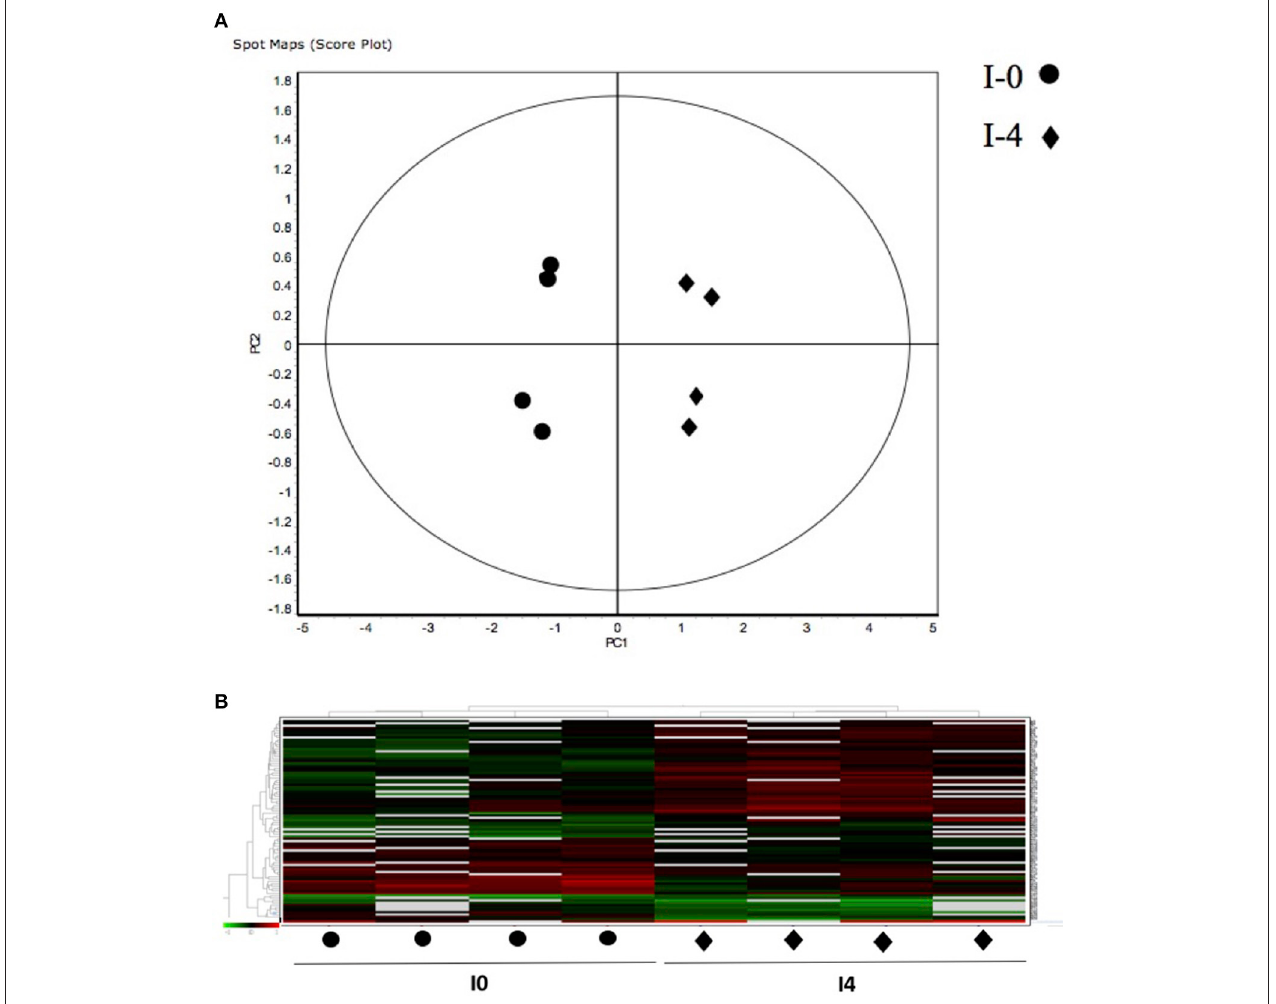
FIGURE 2 | (A) Principal Component Analyses (PCA) and (B) hierarchical cluster analyses of the protein spots (sub-sets) differentially expressed of paralarvae of Octopus vulgaris corresponding to the condition 1 (I4 vs. I0) considered as function of dietary group and age (details in Supplementary Table 3). % of variance explained: PC1 = 66.6; PC2 =